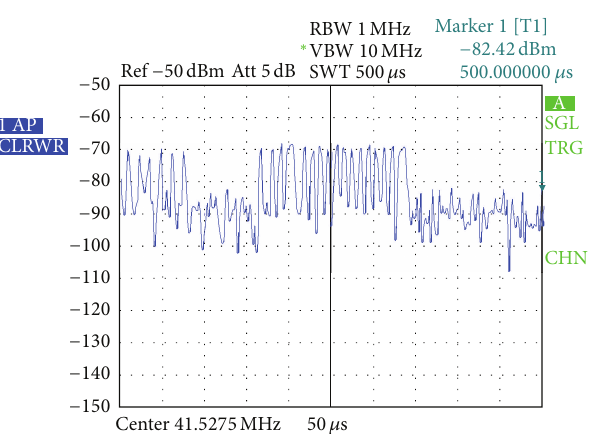
This setup can be used as a reference for different methods of spurious emission